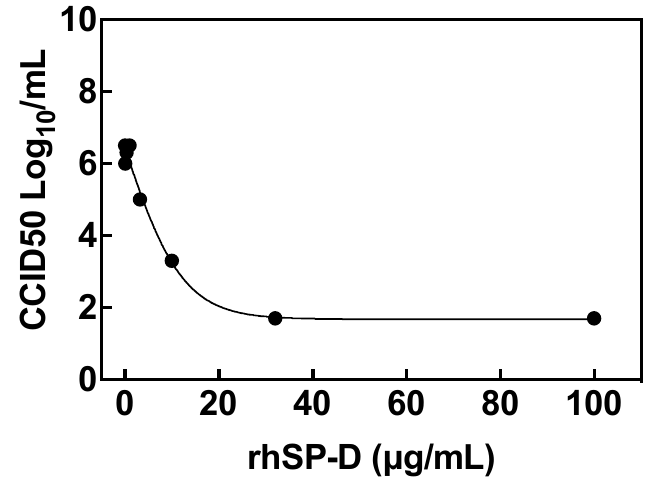
Figure 4. rhSP-D inhibits SARS-CoV-2 cell replication. Viral titers in cells after infection with SARS-CoV-2 and treatment with rhSP-D at different concentrations. The viral titer in the cell supernatant is reported as CCID50 (50% cell culture infectious dose). Individual data points represent the average of three replicates. The concentration of rhSP-D to inhibit viral replication by 90% (EC 90 ) was 3.7 µ g/mL.